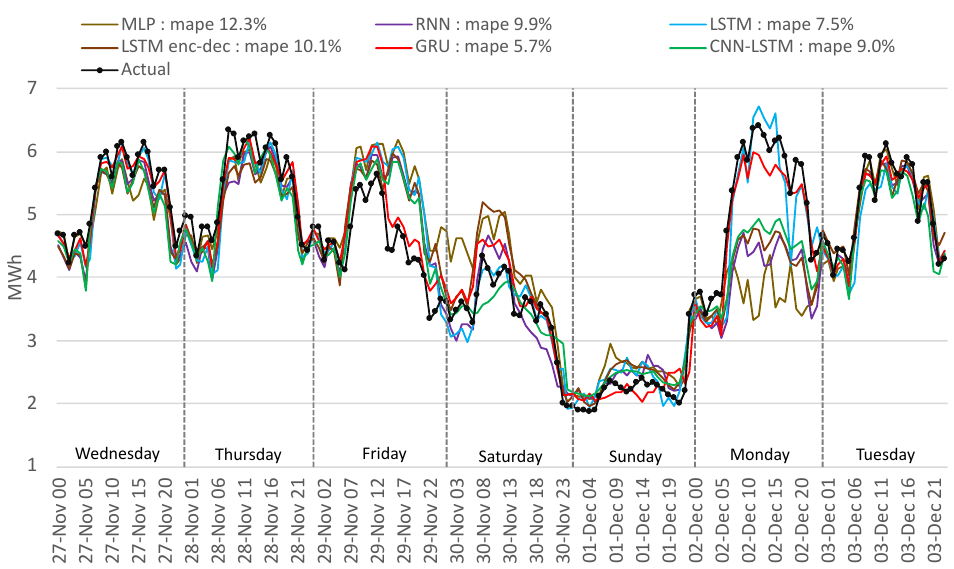
Figure 17. Comparison of actual with forecasted consumption—ML methods. This outcome is similar to the traditional methods for the LSTM encoder–decoder, CNN-LSTM, RNN, and MLP. GRU and LSTM perform well in this period; Figures 18 and 19 highlight a similar performance, but the GRU can better identify the load curve on Friday and Monday and outperform overall the LSTM.